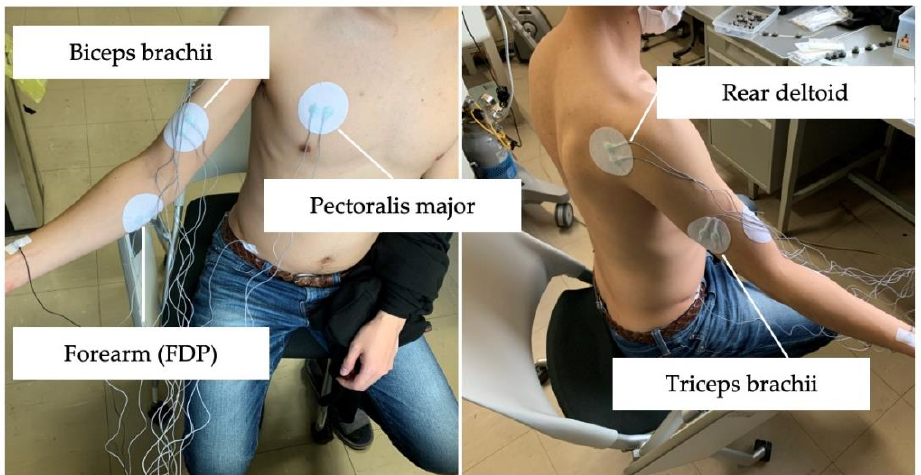
Figure 5. Attachment position for